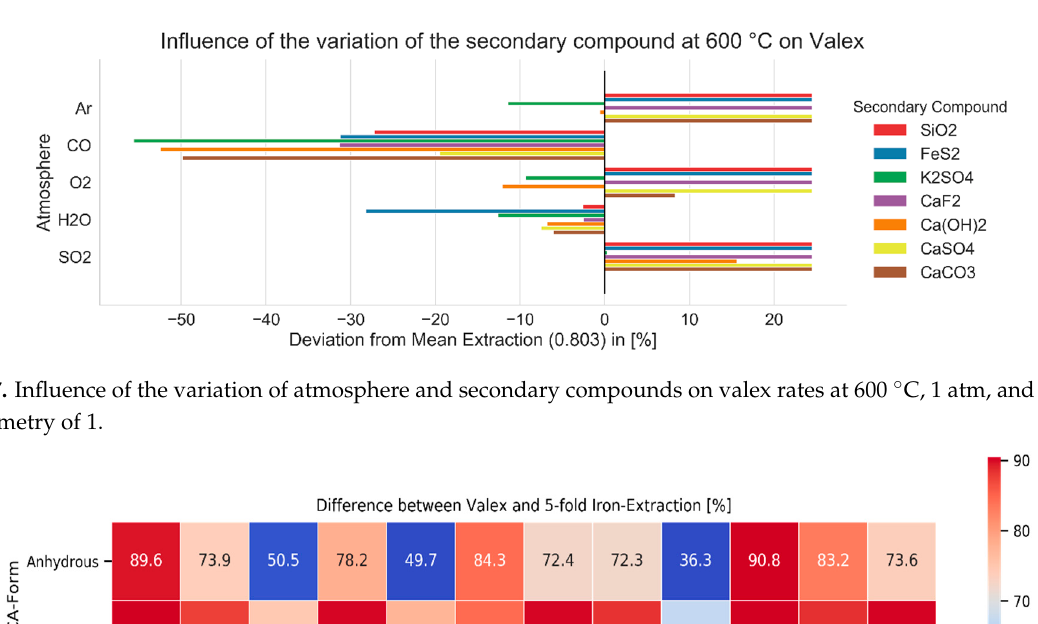
Figure 7. Influence of the variation of atmosphere and secondary compounds on valex rates at 600 °C, 1 atm, and chlorine stoichiometry of 1 .